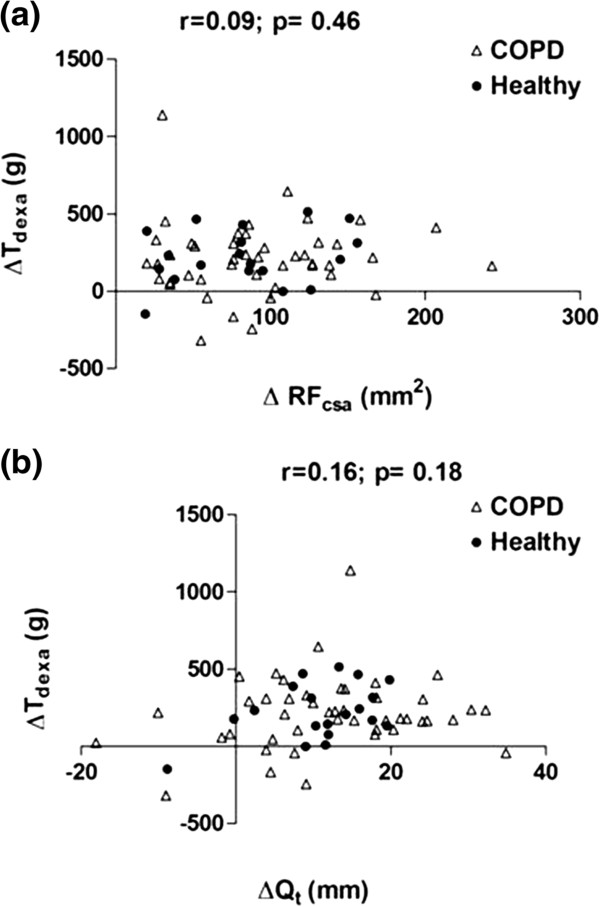
The relationship between training-induced changes in ultrasound and DEXA indices of quadriceps mass (a) ΔTdexavs. ΔRFcsa, and (b) ΔTdexavs. ΔQt.